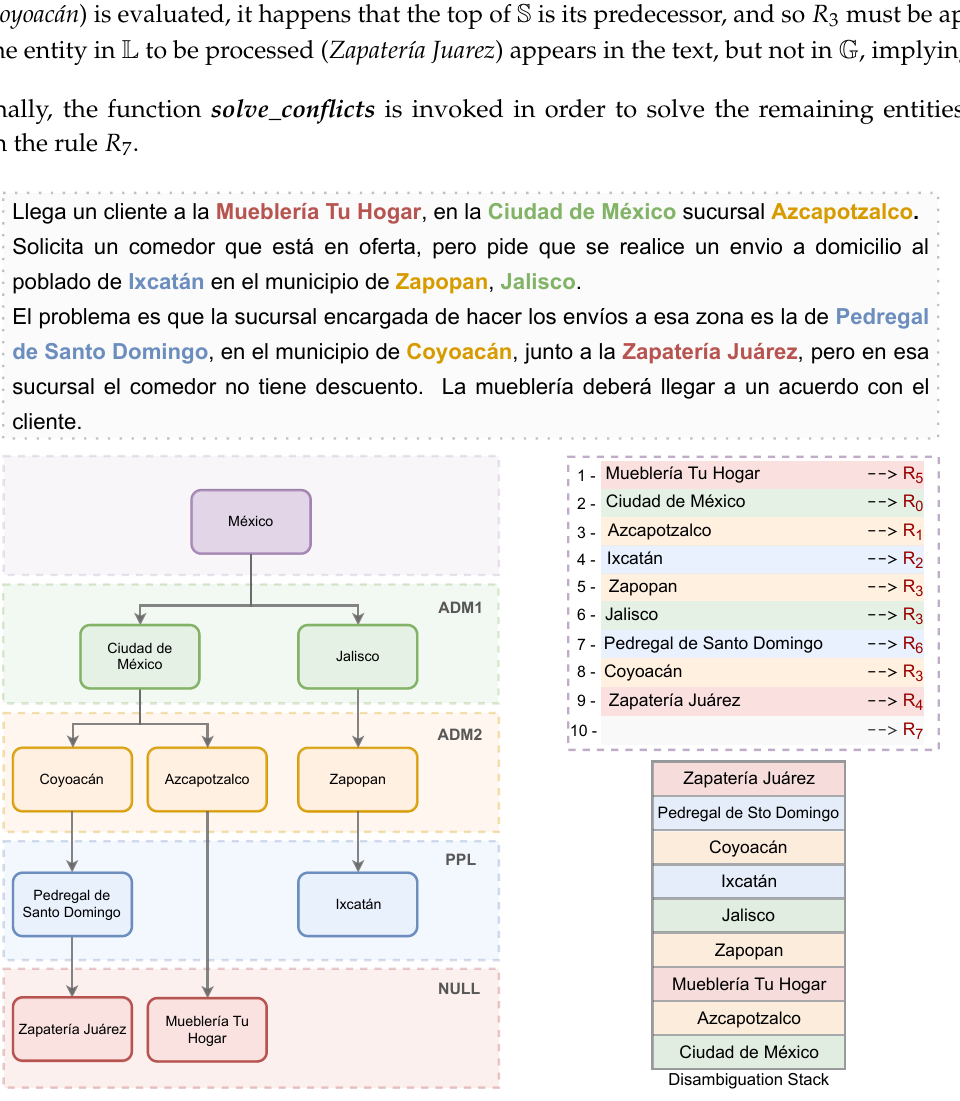
Figure 2. Example of toponym resolution processes based on dynamic context identification for a text in Spanish. The left diagram represents the inherent hierarchy derived from the text. The top right lists the rules applied to every entity, and the bottom right shows the final state of S